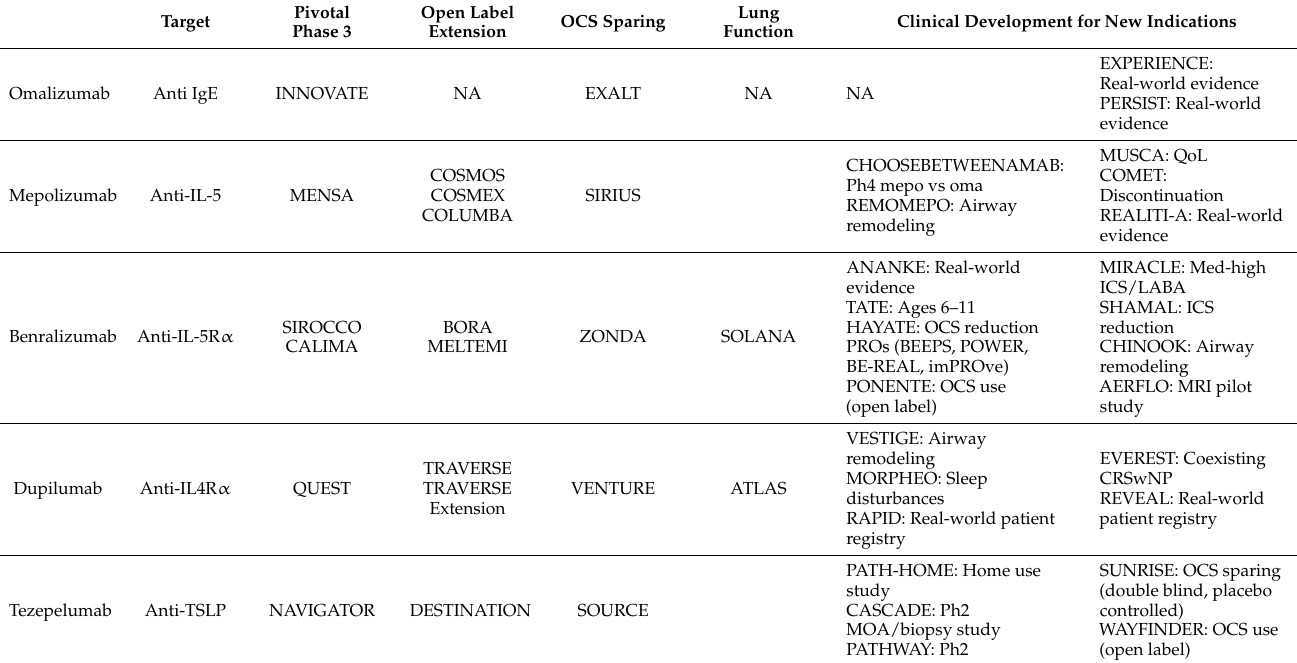
Table 2. Clinical development